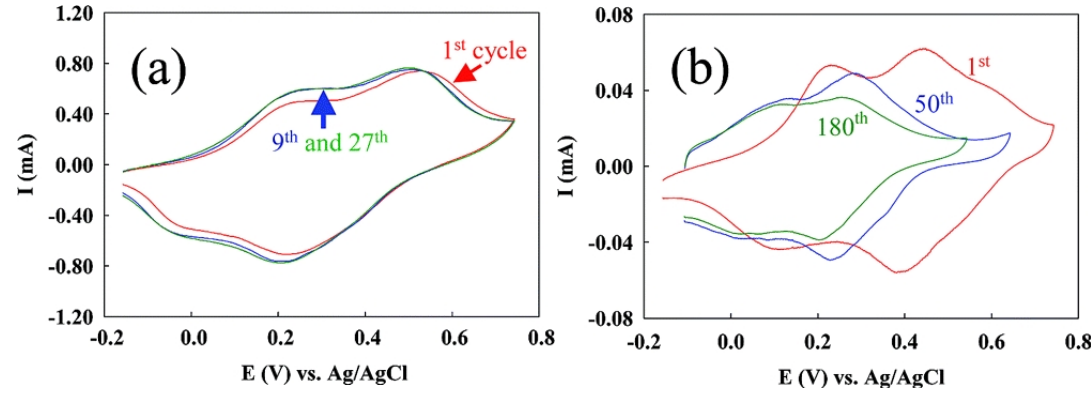
Figure 4. Successive cyclic voltammograms of poly(anilineboronic acid) in H solutions on electrodes (a) with ss-DNA/SWNTs and (b) without ss-DNA/SWNTs; potential scan rate: 100 mV s -1 (Reproduced with permission from the American Chemical Society